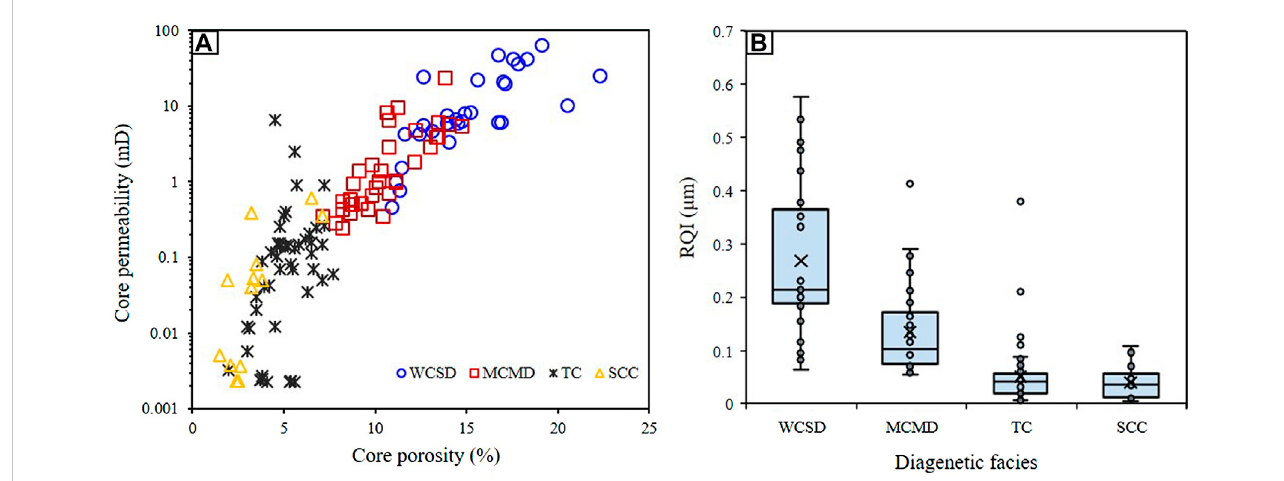
FIGURE 10 (A) The porosity-permeability cross plots of the various diagenetic facies. (B) Box-whisker plots viewing the variance in RQI among various diagenetic facies. The legend is the same as Figure